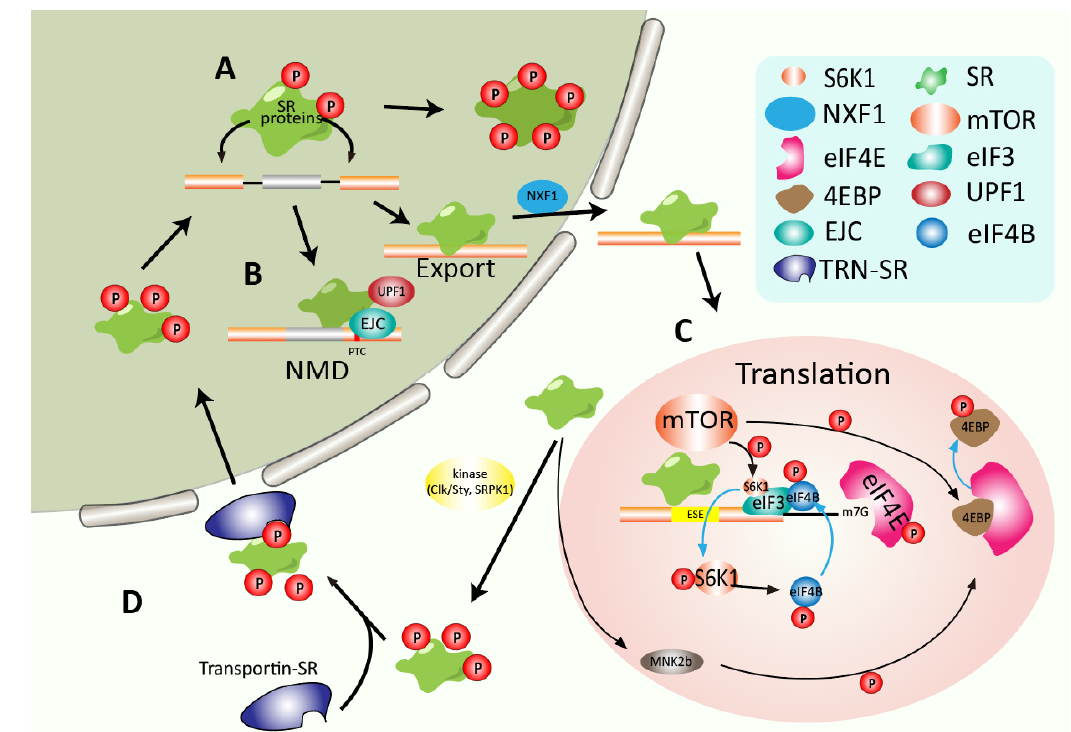
Figure 4. Regulation of SR proteins and their roles in mRNA export, translation, and decay. ( A ) SR proteins require phosphorylation to mediate spliceosome complex formation. With further dephosphorylation, SR proteins bind and export the mature mRNA into the cytoplasm. ( B ) SR proteins perform a significant role in NMD, which can alter NMD from taking place after mRNA export to the cytoplasm to coming up before mRNA release from the nucleus. ( C ) SR protein-bound mRNAs recruit the mTOR kinase resulting in the phosphorylation and release of 4E-BP, leading to enhanced translation initiation. SR proteins can enhance the mTOR kinase phosphorylating S6K1, which promotes translation initiation. Meanwhile, The SF2/ASF-dependent alternative splicing leads to Mnk2b isoform, which can activate translation. ( D ) Phosphorylated by kinase, such as SRPK1 or/and Clk, SR proteins are specifically recognized and transported into the nucleus by Transportin-SR protein.